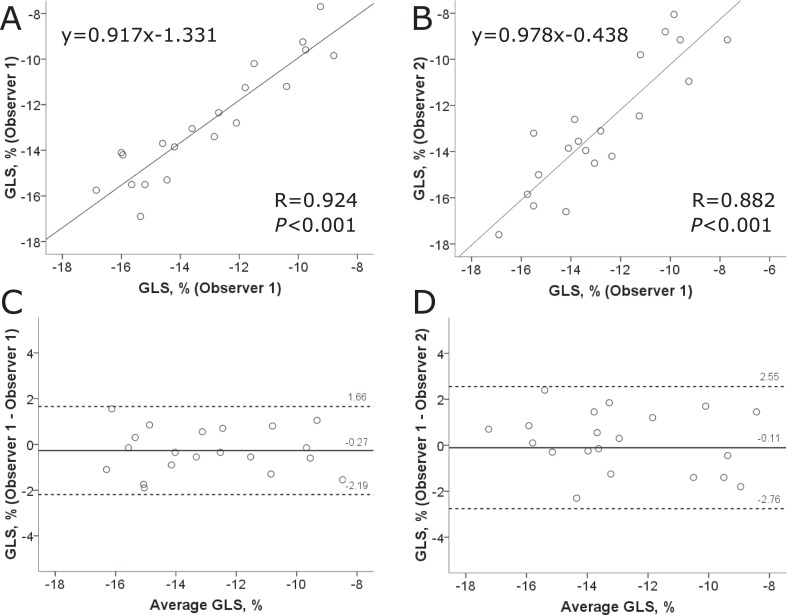
CMR-FT GLS reproducibility.Linear Regression and Bland-Altman plots illustrating intra- (A, C) and interobserver variability (B, D) of global longitudinal strain (GLS) measurements in a subset of randomly selected patients.